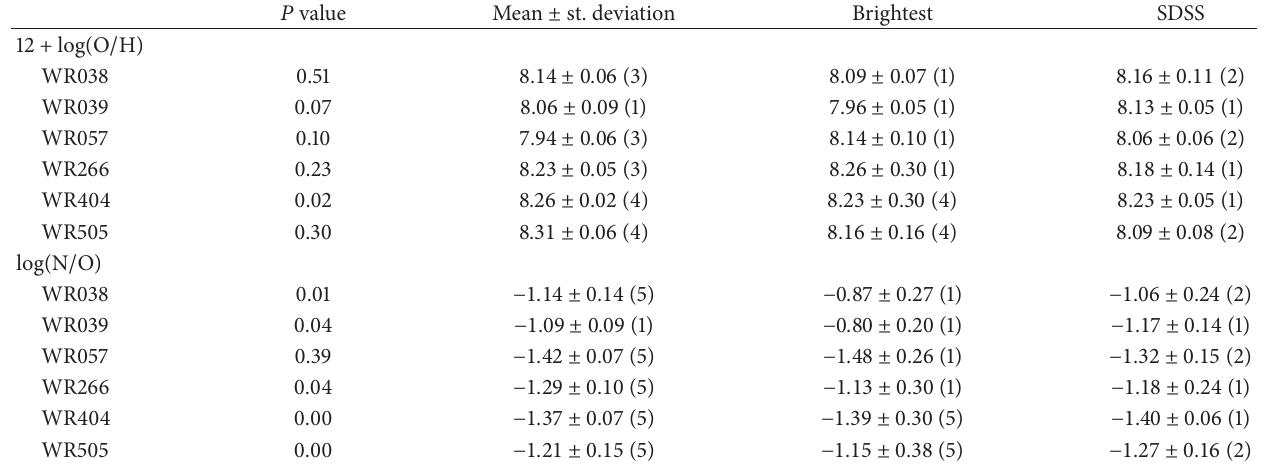
Table 2: Total oxygen abundances and N/O derived for the six studied WR galaxies using different methods as described in the text. The confidence level from the Lilliefors test for those spaxels where all involved emission lines were measured is the 𝑃 value. Column (3) lists the mean value and standard deviation (sigma) from the Gaussian fit as long as 𝑃 value > 0.05; otherwise, the mean value and sigma of the data distribution are shown. Column (4) and (5) show the O/H, N/O, and their corresponding errors derived from the brightest spaxel and from the SDSS spectrum for each galaxy, respectively. The number in parenthesis indicates the method used to derive the chemical abundances: (1) from direct method with [O II] 3727 ˚A, (2) from direct method with [O II] 7319, 7330 ˚A, (3) from N2, (4) from O3N2, and (5) from N2O2. 𝑃 value Mean ± st. deviation Brightest SDSS 12 + log ( O / H